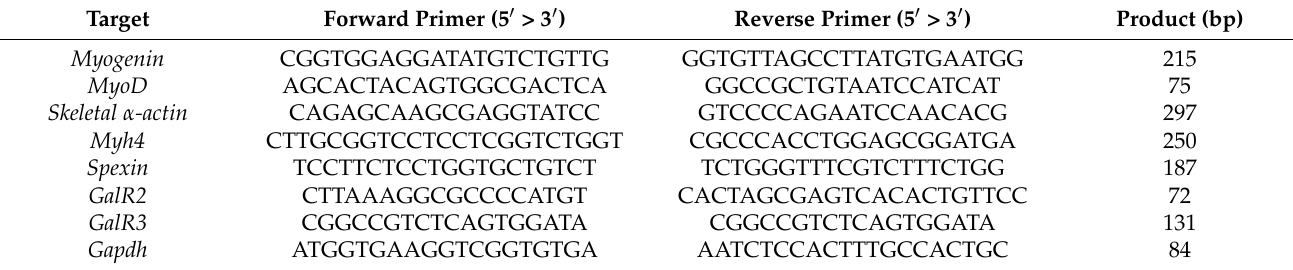
Table 1. Primer sequence used for real-time